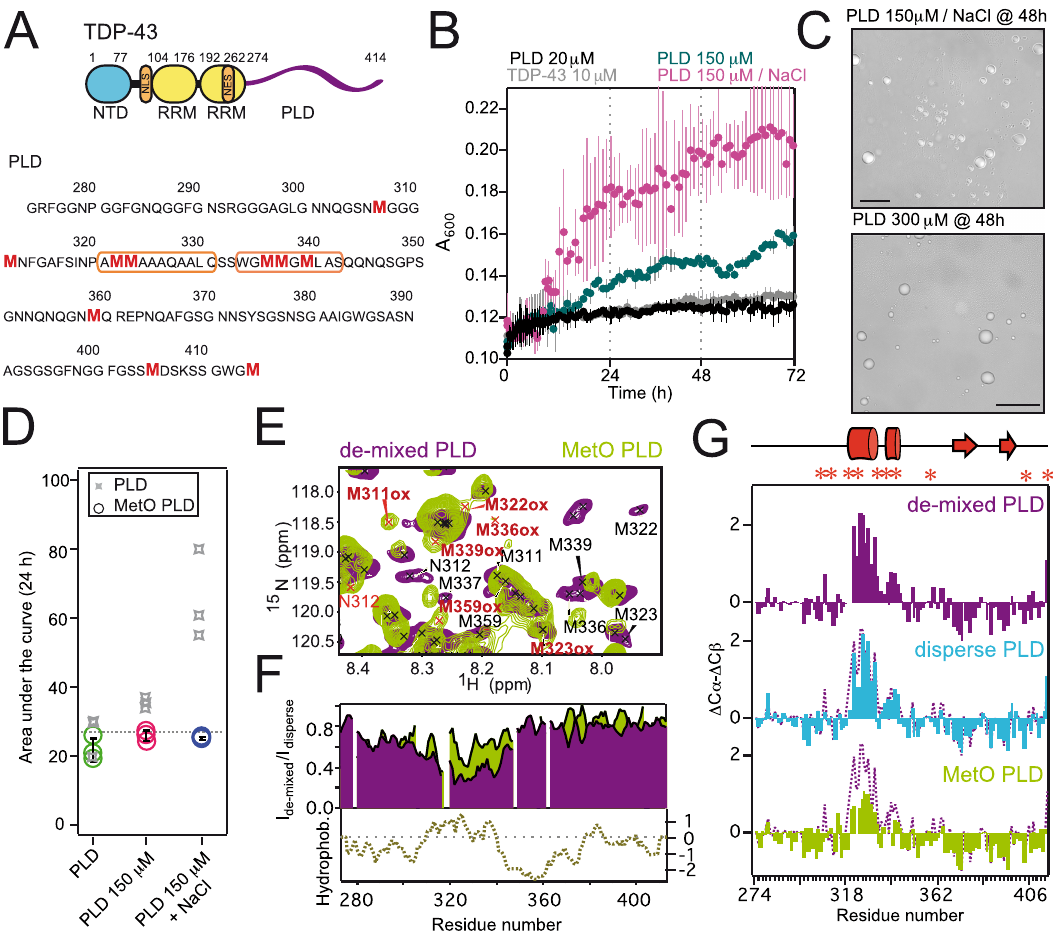
Fig. 1 | Methionine sulfoxidation impairs TDP-43 ’ s PLD phase separation by reshaping its structure. A Cartoon representation of the domain architecture of TDP-43(top).ThedisorderedPLD(region274 – 414)isrepresentedbyapurpleline. PLD primary structure, with the Met residues highlighted in red (bottom). The double α -helices are limited by orange boxes. B Turbidity measurements showing concentration- and salt-dependent LLPS for the PLD. C Differential Interference Contrast (DIC) microscopy images showing liquid condensates formed by the PLD inthespeci fi edconditions.Scalebarscorrespondto25 μ M. D LLPSofMetOPLDin the corresponding samples (circles), compared to unmodi fi ed PLD (gray stars), as measured by the area under the turbidity curves after 24h of incubation. Gray brokenlinecorrespondstotheaveragedLLPSofunmodi fi edPLD. E Detailedregion of the overlay of the 15 N-HSQC spectra from de-mixed PLD (purple) and MetO PLD (green) showing the large shifts for the Met moieties upon methionine sulfoxida- tion. MetO cross peaks are highlighted in red. F Comparison of the NMR signal